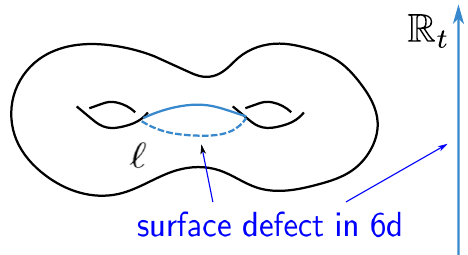
Figure 3 . We consider a surface defect in the 6d (2 , 0) gl (3) theory, wrapping a simple closed curve ‘ on the Riemann surface C and extending along the R t direction. After the compactification on C , this produces a line defect extending along the R direction in the 4d class S theory of type gl (3) . t